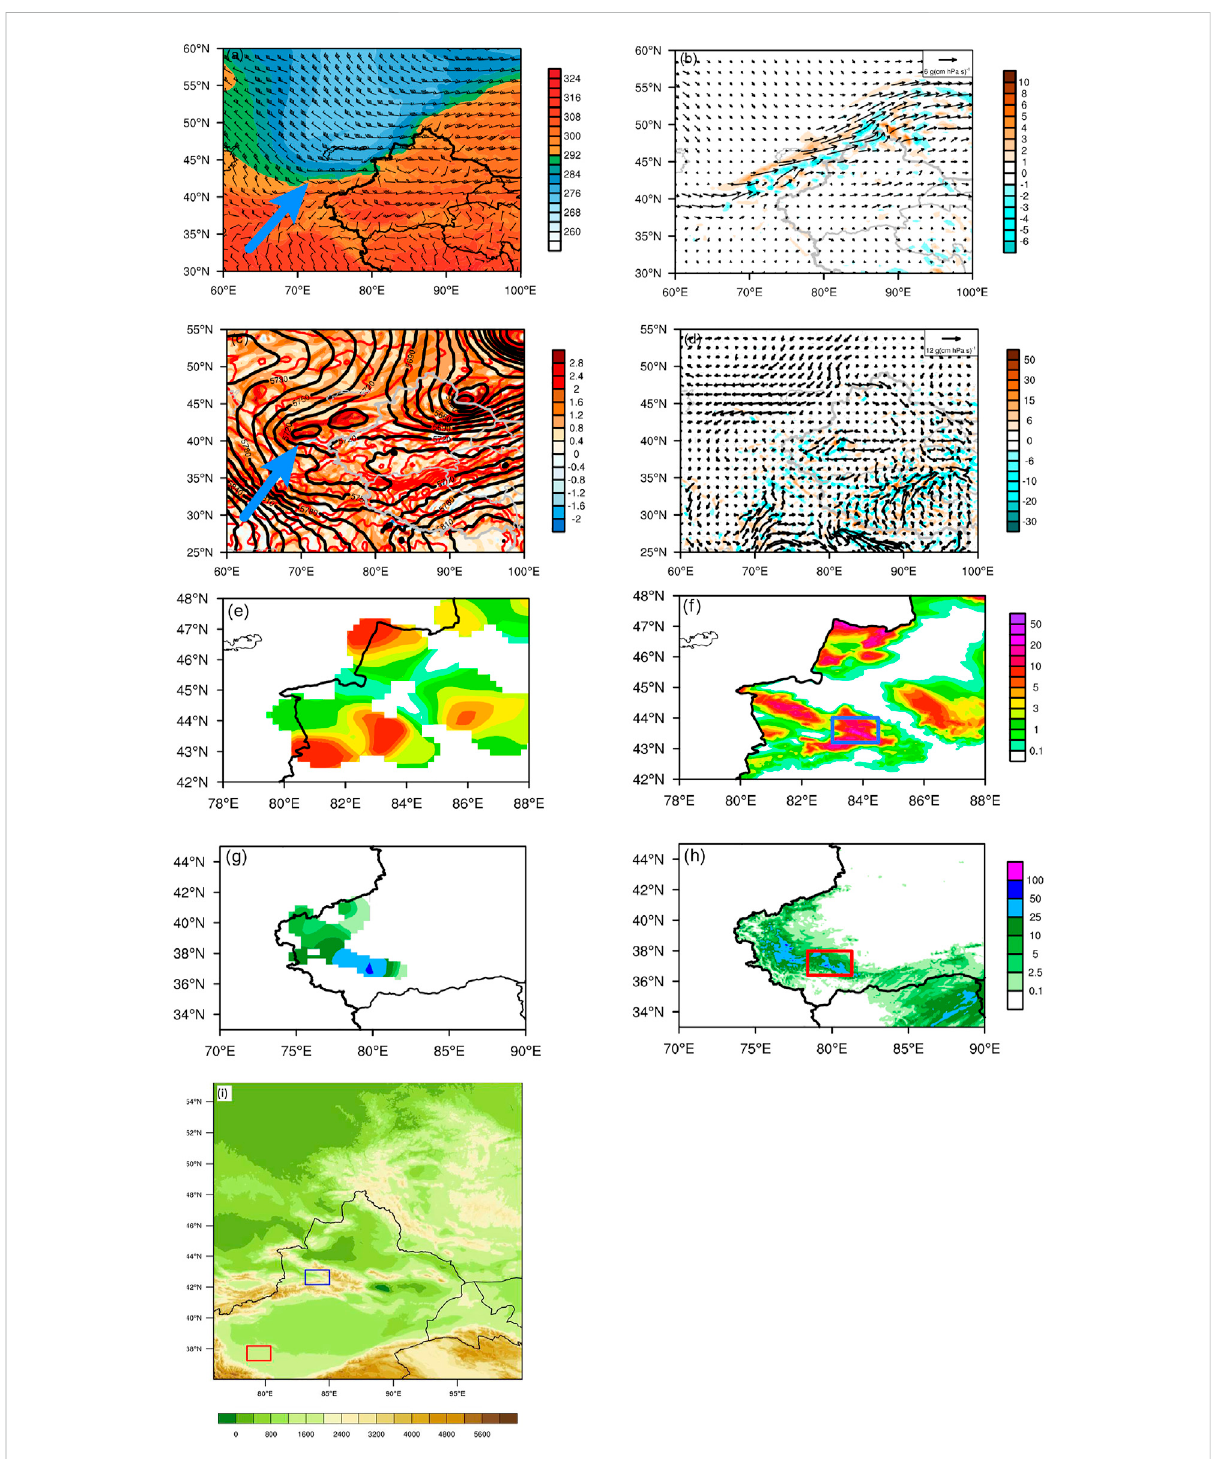
FIGURE 1 (A) Windvectorandequivalenttemperature(shaded,units:(K)and (B) watervapor fl ux(vector,unit:g cm − 1 hPa − 1 s − 1 )anditsdivergence(shaded, unit: 10 − 7 g cm − 2 hPa − 1 s − 1 ) at 700 hPa at 12 UTC 30 November 2018, (C) geopotential (solid contours, unit: gpm), temperature (dashed contours, unit: K), and relative vorticity (shaded, unit: 10 − 4 s − 1 ) at 500 hPa and (D) water vapor fl ux (vector, unit: g cm − 1 hPa − 1 s − 1 ) and its divergence (shaded, unit: 10 − 7 g cm − 2 hPa − 1 s − 1 ) at 850 hPa at 00UTC on 15 Jun, 2021. Twelve hour-accumulated observed rainfall (E) and simulated results (F) at 00UTCon1Dec,2018. (G) and (H) arethesameas(E)and(F)correspondinglyexceptforat00UTCon16June,2021.Unitsaremm. (I) Terrainheights in the unit of m. The blue and red rectangular regions in Figures 1F,H are the target domains for the following